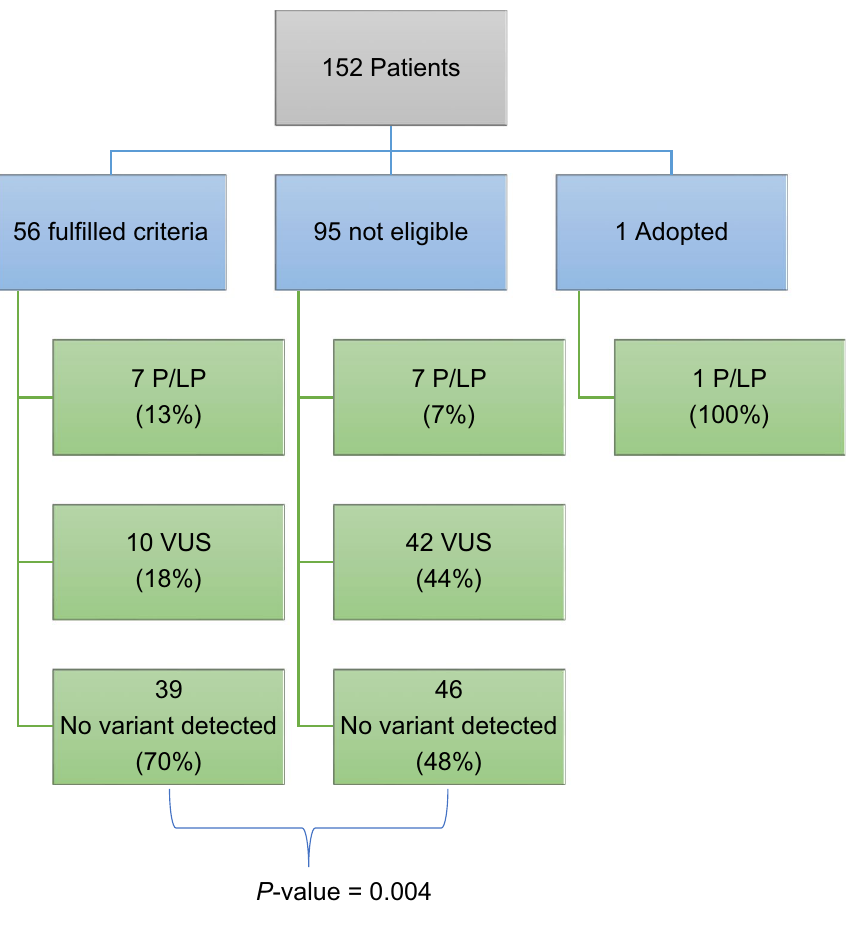
Figure 4. Overall results of gene panel testing, grouped by fulfilment of eligibility criteria. The individual who was adopted was excluded from this calculation as accurate estimation of family history was not